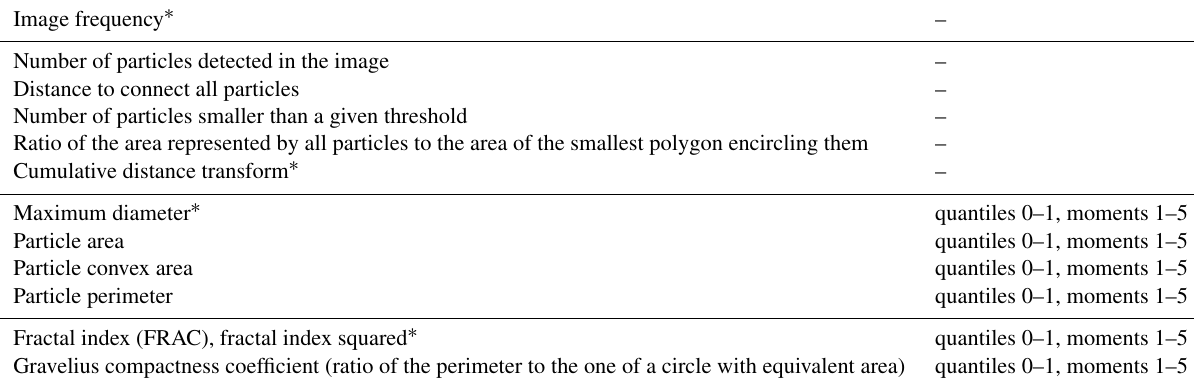
Table A1. Full list of all computed descriptors. Descriptors related to each particle are transformed into a single descriptor for the image (right column). Selected ones are shown with an